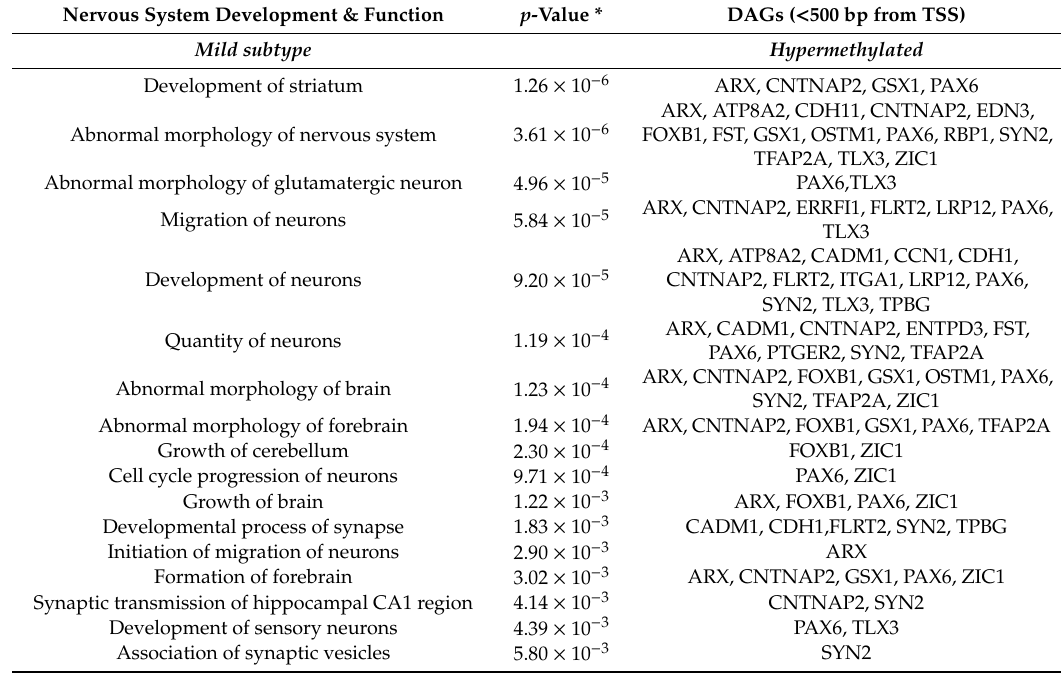
Table 5. Neurological functions enriched among DAGs implicated by CpGs within 500 bp from the TSS in the mild